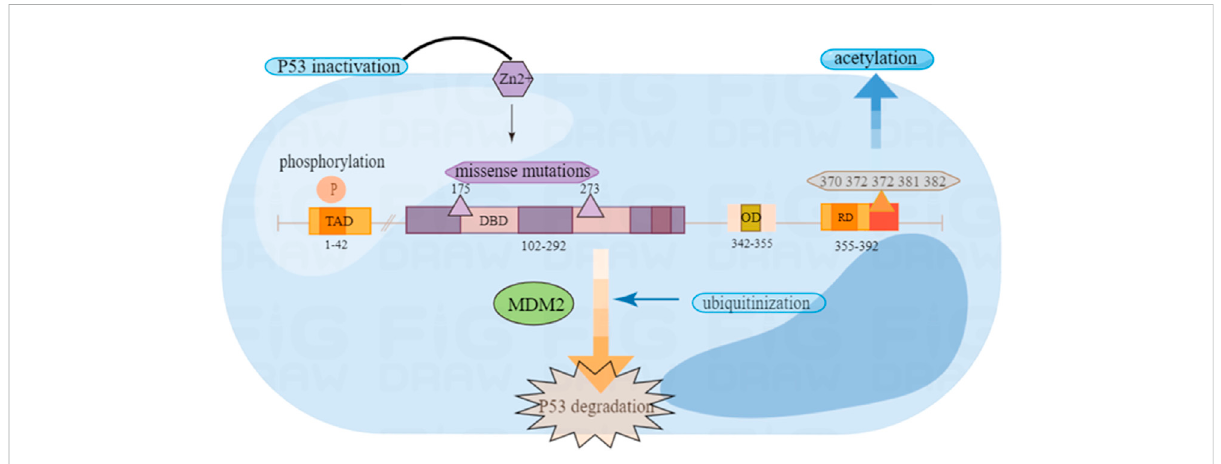
FIGURE 1 Wild type P53 structure and common mutation sites.